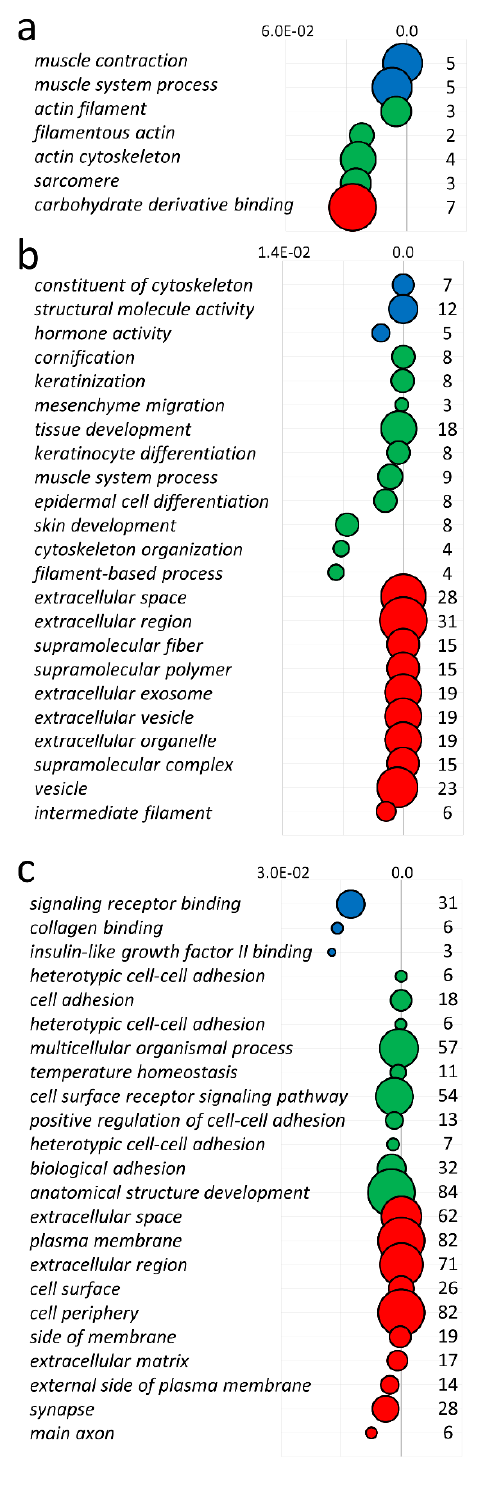
Figure 4. Gene Ontology enrichment plot of the top 10 categories, classified by p -values (x-axis of the plots), of downregulated ff-FGR ( a ), and upregulated ( b ) and downregulated ( c ) mf-FGR genes. The circles represent terms described along the y-axis, colors reflect the GO classes: blue—molecular function, green—biological process, red—cellular component. Each circle’s area corresponds to the number of genes (numerical values near to circles) enriched in each term.